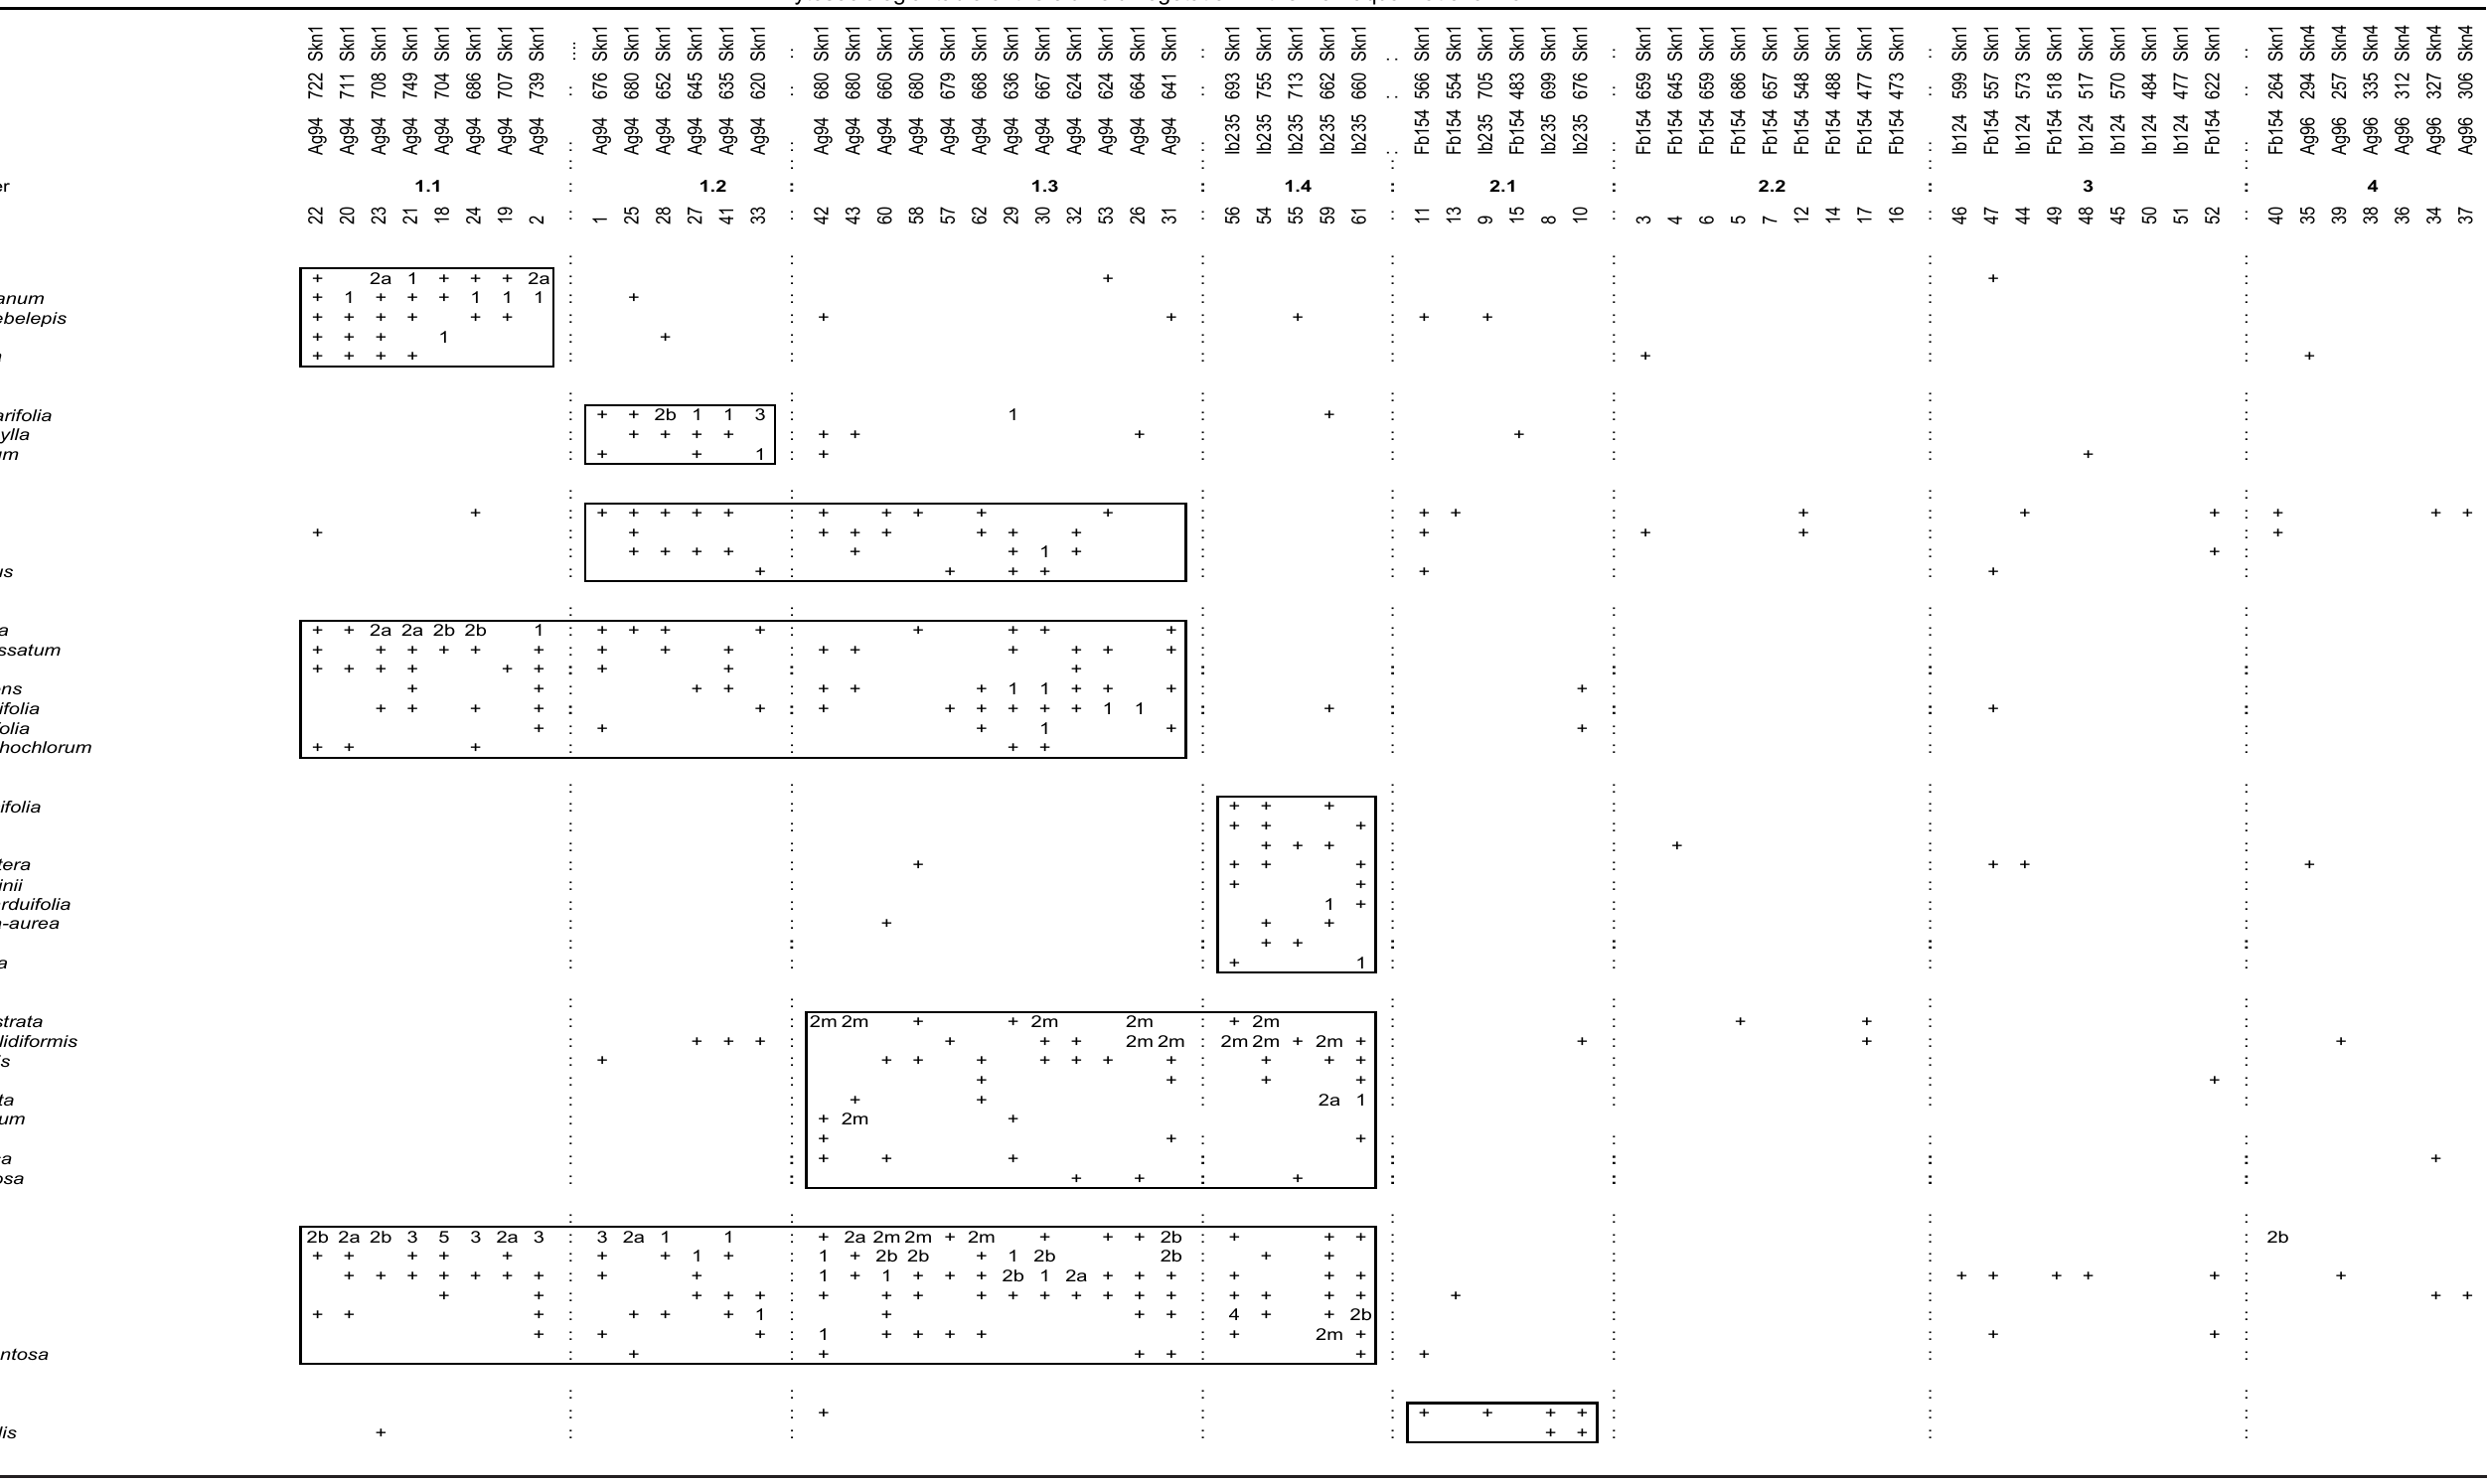
Species group A